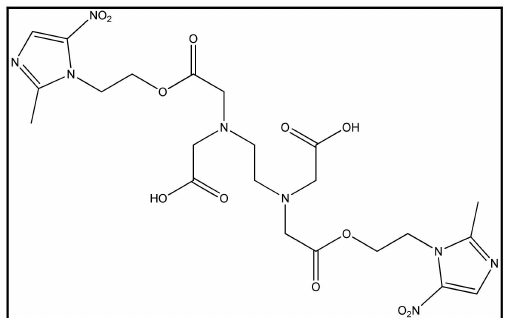
Figure 2. Molecular structure of 5-nitroimidazol– ethylenediaminotetraacetic acid (EDTA–MN), a ligand used for direct labelling with [ 99m Tc]Tc